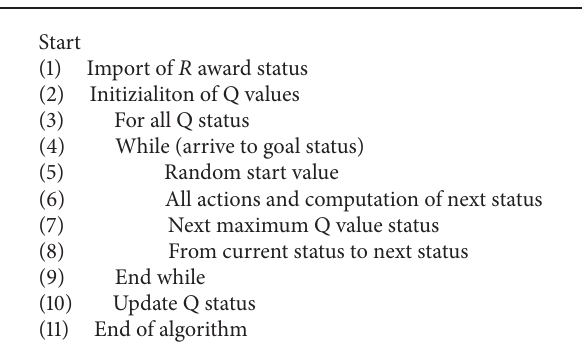
Pseudocode 3: The pseudocode of Q learning